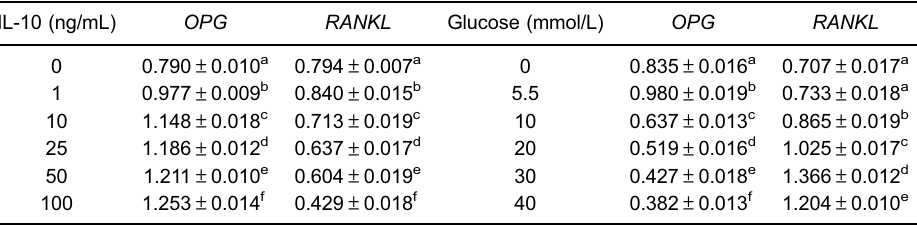
Table 3. Relative protein expression of osteoprotegerin (OPG) and receptor activator of nuclear factor- k B ligand (RANKL) in human periodontal ligament fi broblasts after interleukin-10 (IL-10) or glucose treatment. IL-10